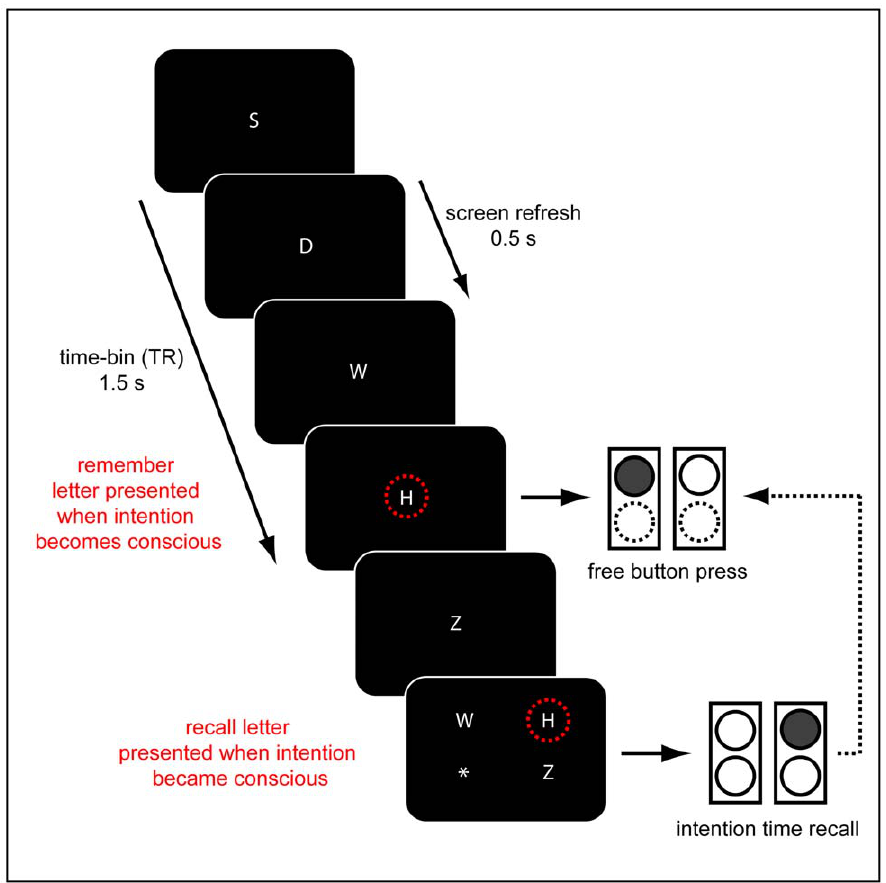
Figure 1. Experimental paradigm. Subjects were presented with a stream of constantly changing white letters on dark background. The screen was refreshed every 500 ms. The task was to freely and spontaneously decide to press a response button with the left or the right index finger (illustrated by upper circles; decision for left button in example illustrated by filled circle) whenever they felt the urge to do so. They were instructed to note the letter displayed on the screen when they became aware of their intention and to immediately perform the button press (the letter H in the example; red circles are for illustration and were not presented). Following the button press, a response screen was presented. Three letters and an asterisk were presented in the four corners of the screen, the letters being those shown during and immediately prior to the button press. Subjects indicated the letter that was visible at the time of the decision by pressing the button corresponding to its position on screen (recalled letter H, indicated by upper right button in example). If they could not remember the letter or if the relevant letter was not present, they indicated this with the asterisk. After the response was given, the next trial started and subjects were instructed to return to a relaxed state before making a new decision. The general paradigm was taken from Soon et al.